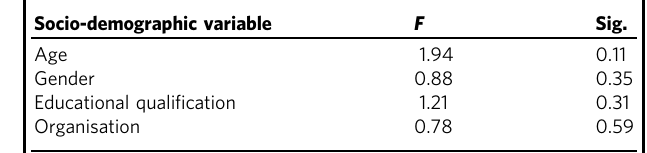
Table 5 Stability analysis of simultaneous equation systems. Table 6 Respondents ’ perception and demographic